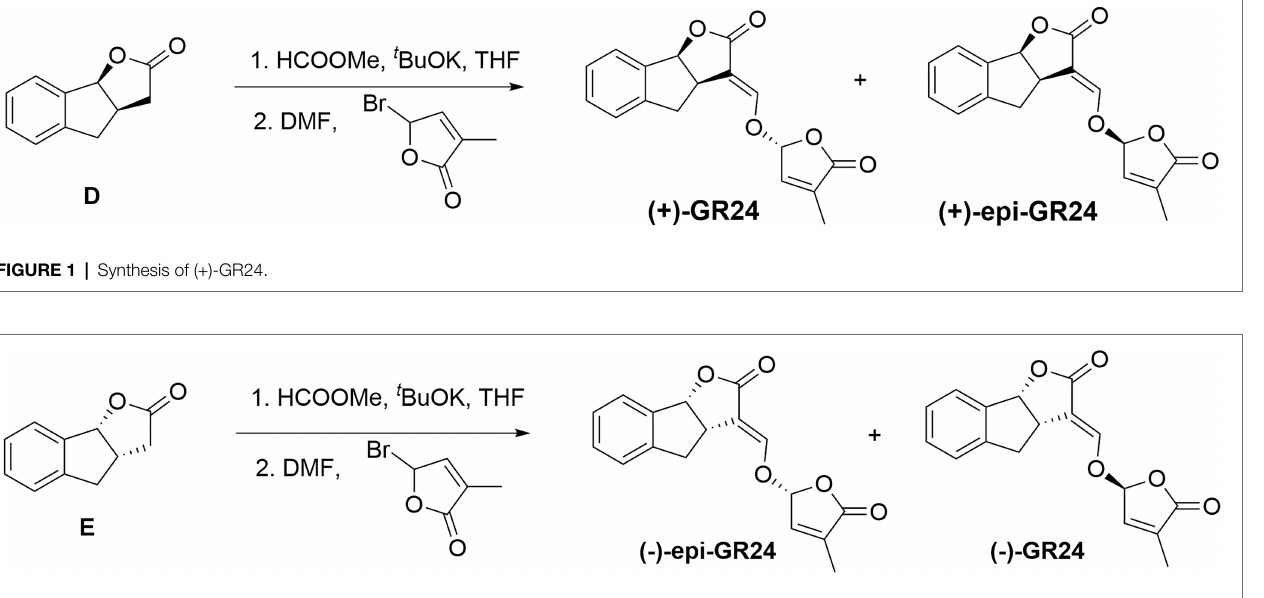
FIGURE 2 | Synthesis of ( − )-epi-GR24.